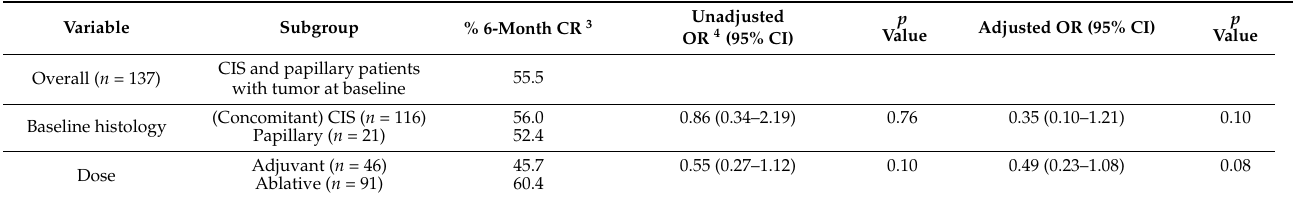
Table 2. Complete response rates.